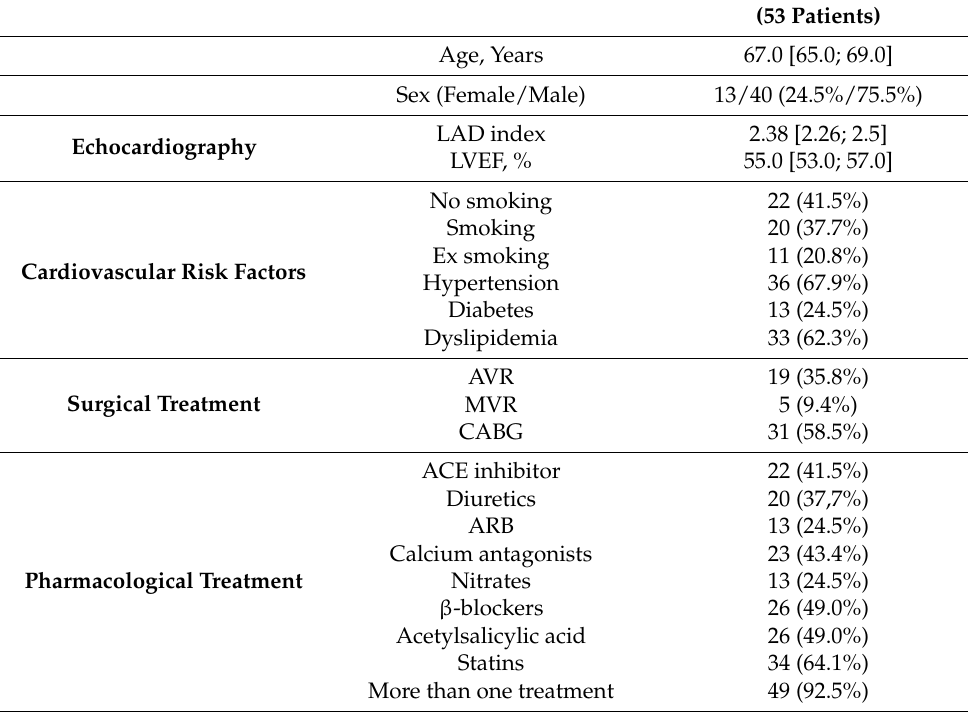
Table 1. Clinical characteristics of the study